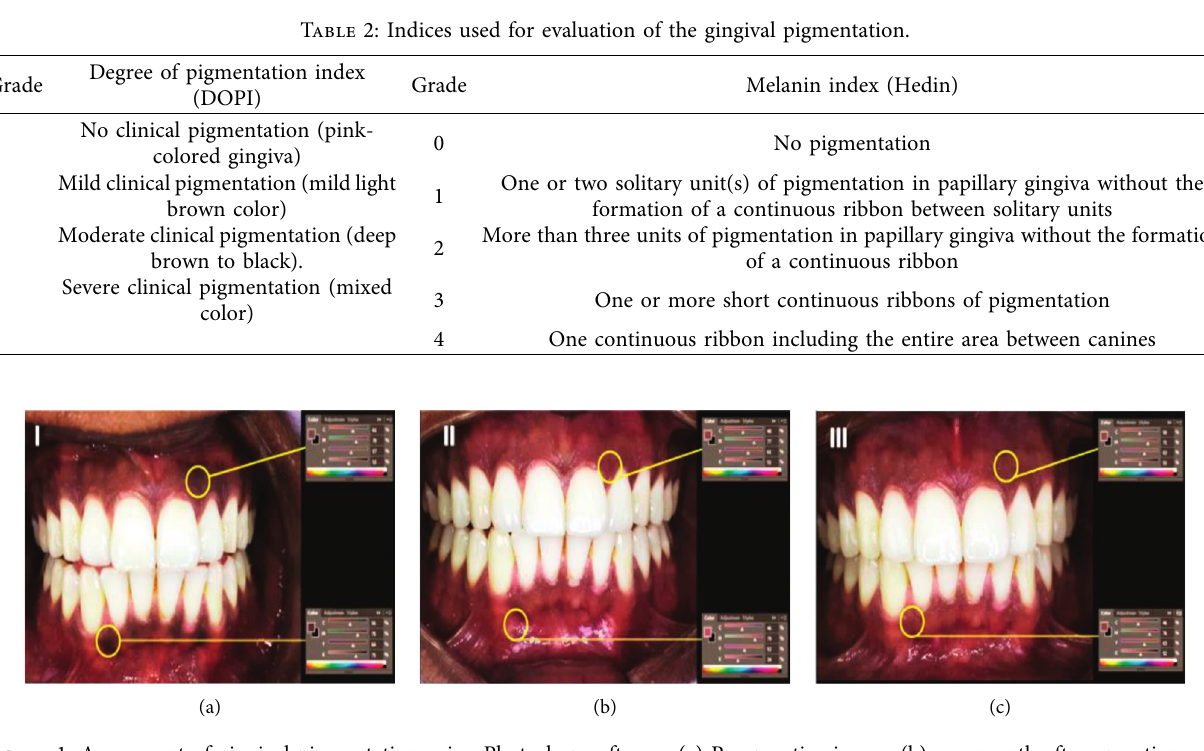
Figure 1: Assessment of gingival pigmentation using Photoshop software. (a) Preoperative image, (b) one month after operation, and (c) three months after